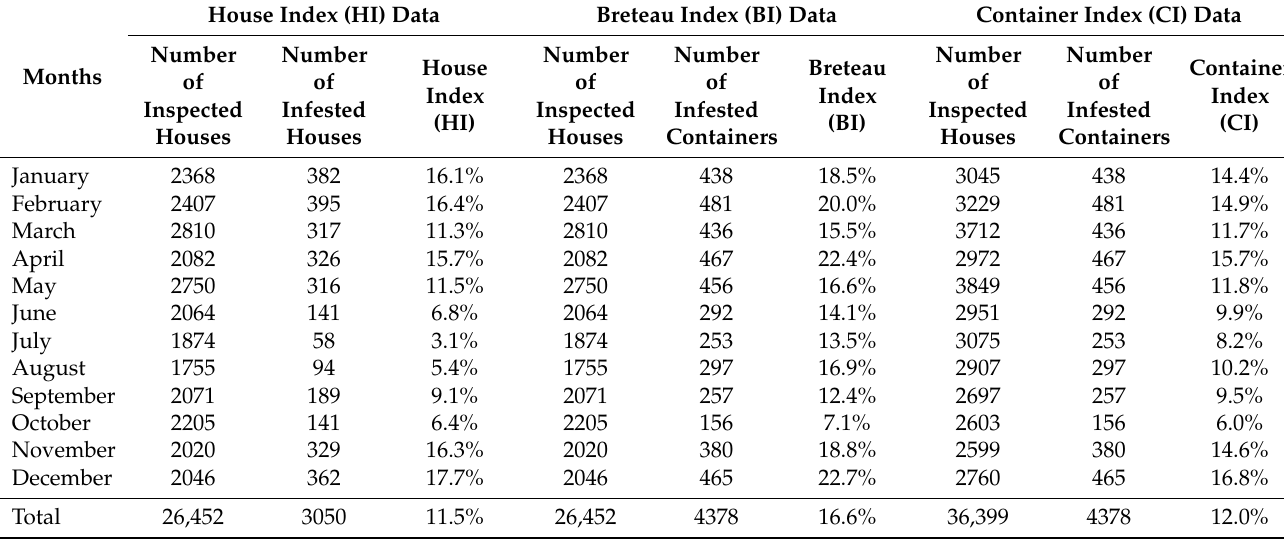
Table 2. The density of Aedes aegypti infested in potential larval breeding sites.